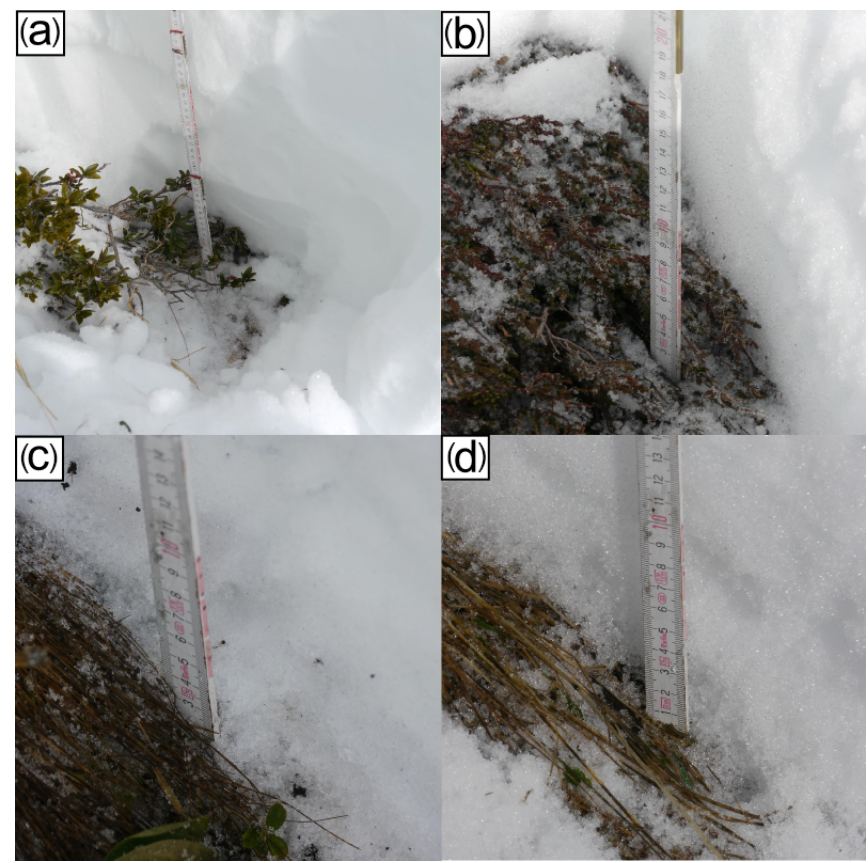
Figure 4. Vegetation below the snow cover. Vegetation heights h v are lower in winter than in autumn: 10–20cm for strong lignified shrubs (a) ,